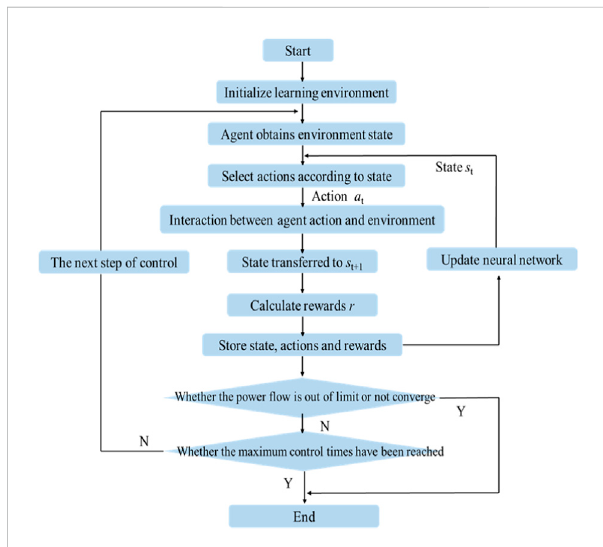
FIGURE 3 Schematic diagram for the process of data-driven